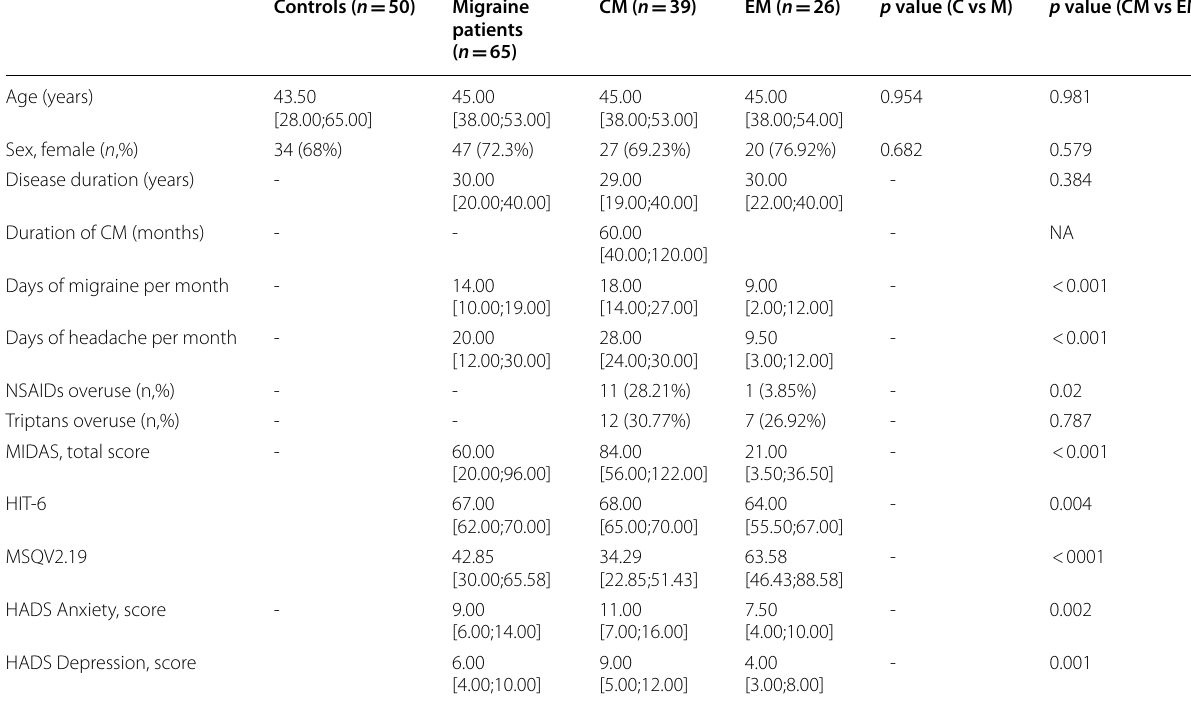
C Controls, M Migraine patients, CM Chronic migraine, EM Episodic migraine, NSAIDs Nonsteroidal anti-inflammatory drugs, MIDAS Migraine Disability Assessment Scale, HIT-6 Headache Impact Test, MSQV2.19 Version 2 of the Migraine-Specific Quality-of-Life Questionnaire, HADS Hospital Anxiety and Depression